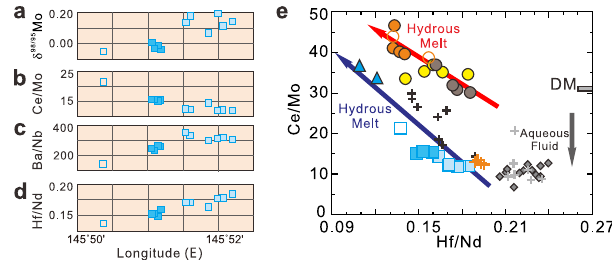
Fig. 4 Chemical variations of Pagan volcanic rocks as a function of longitude and plot of Ce/Mo vs. Hf/Nd for Pagan and NW Rota-1 samples. Plots of a δ 98/95 Mo, b Ce/Mo, c Ba/Nb, and d Hf/Nd vs. longitude for the NE Pagan samples, and e Ce/Mo vs. Hf/Nd for the Pagan and NW Rota-1 samples unaffected by amphibole fractional crystallization. The Izu arc and other Mariana volcanic front volcanoes data are also plotted for comparison. The ranges for depleted mantle (DM) are estimated according to the studies of Workman and Hart 73 and Salters and Stracke 43 . The blue arrows show compositions of magmas formed above increasing slab depth. The symbols and data source are as in